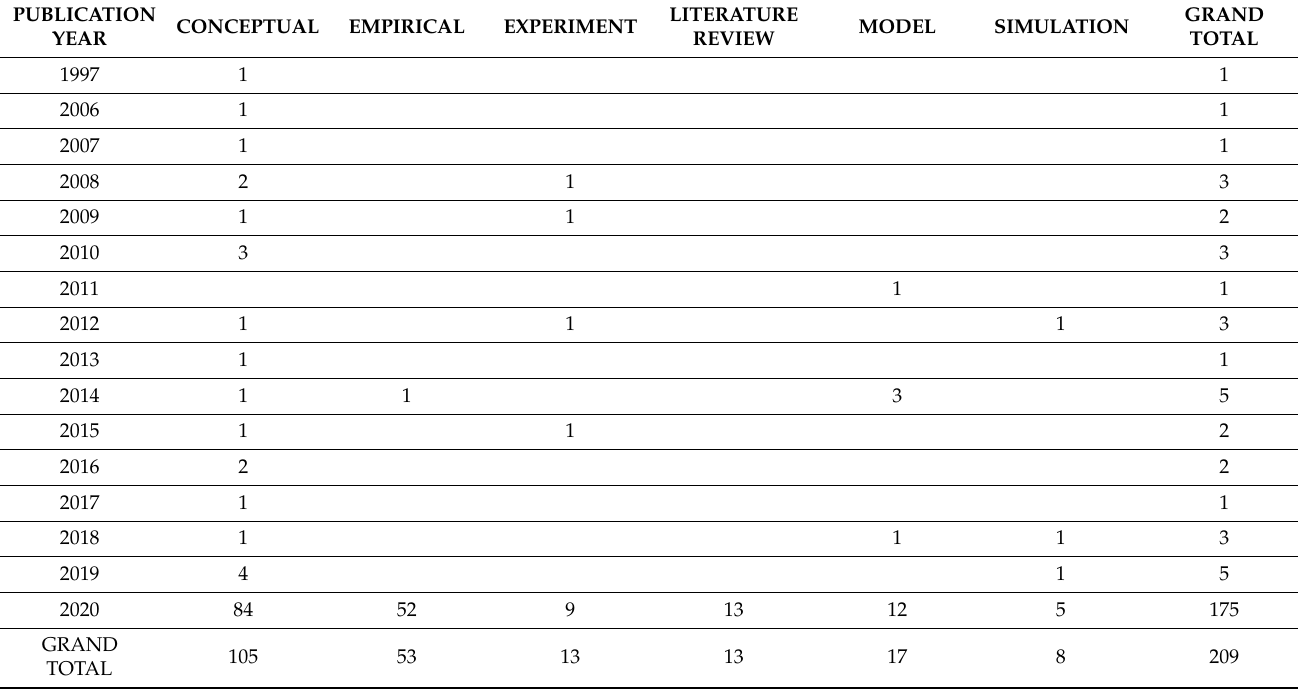
Table 5. Research Articles by Methodology.